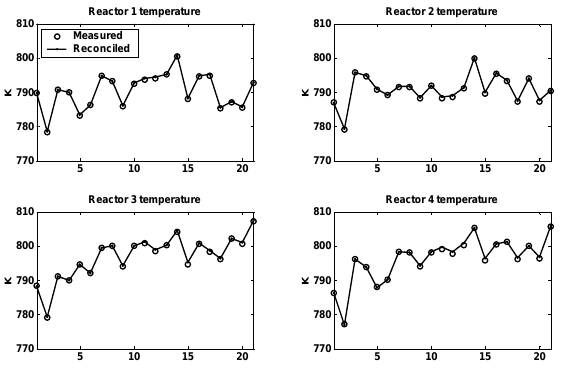
Figure 4: Reconciled reactor inlet temperatures for the 21 data sets